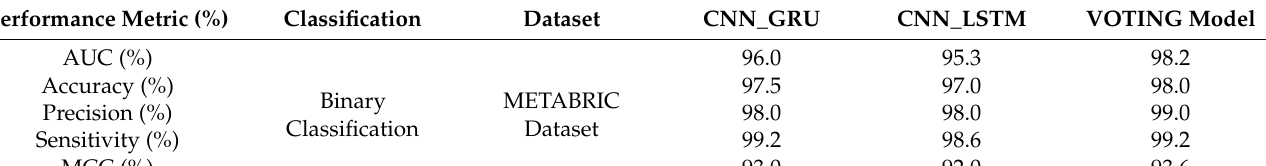
(c) CNN_EXPR ROC CURVE Figure 3. ROC curves and AUC values of CNNs trained on each data modality. 5.2. Performance Metrics of LSTM, GRU, and Voting Classifier with Stacked Features The outcomes of using stacked features with deep learning are shown in Table 10. Figure 4 shows all the classification results. Overall, GRU achieved the highest perfor-